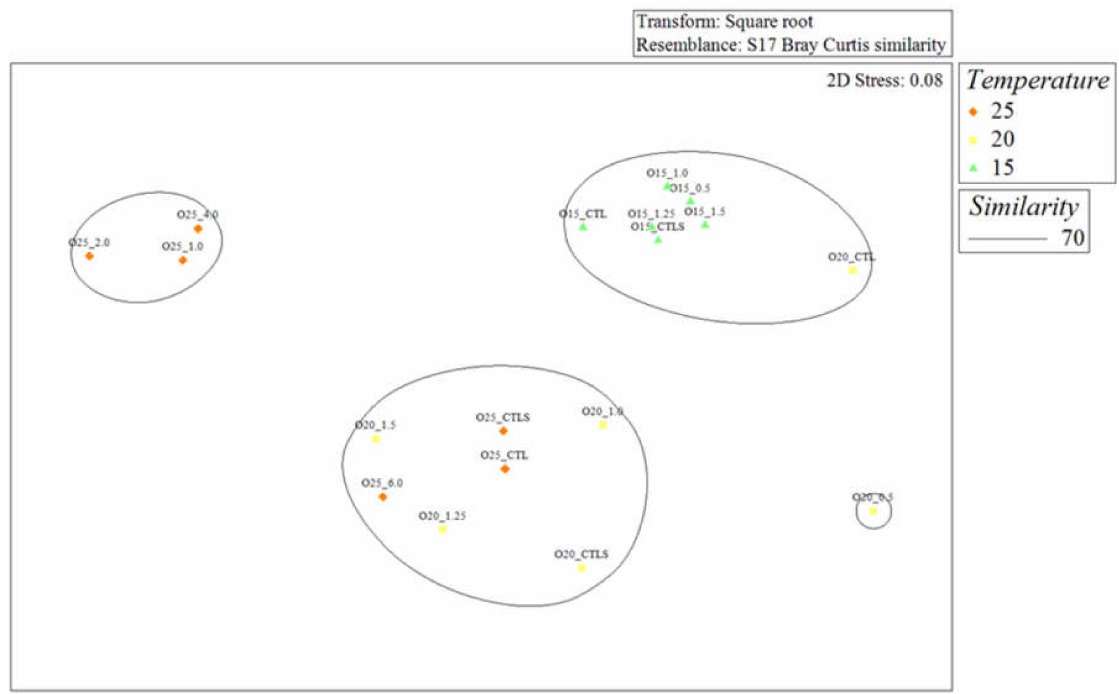
Figure 9. Two-dimensional non-metric MDS ordination plot of the neutral sugar content of the T. weissflogii exposed to oxyfluorfen at the three